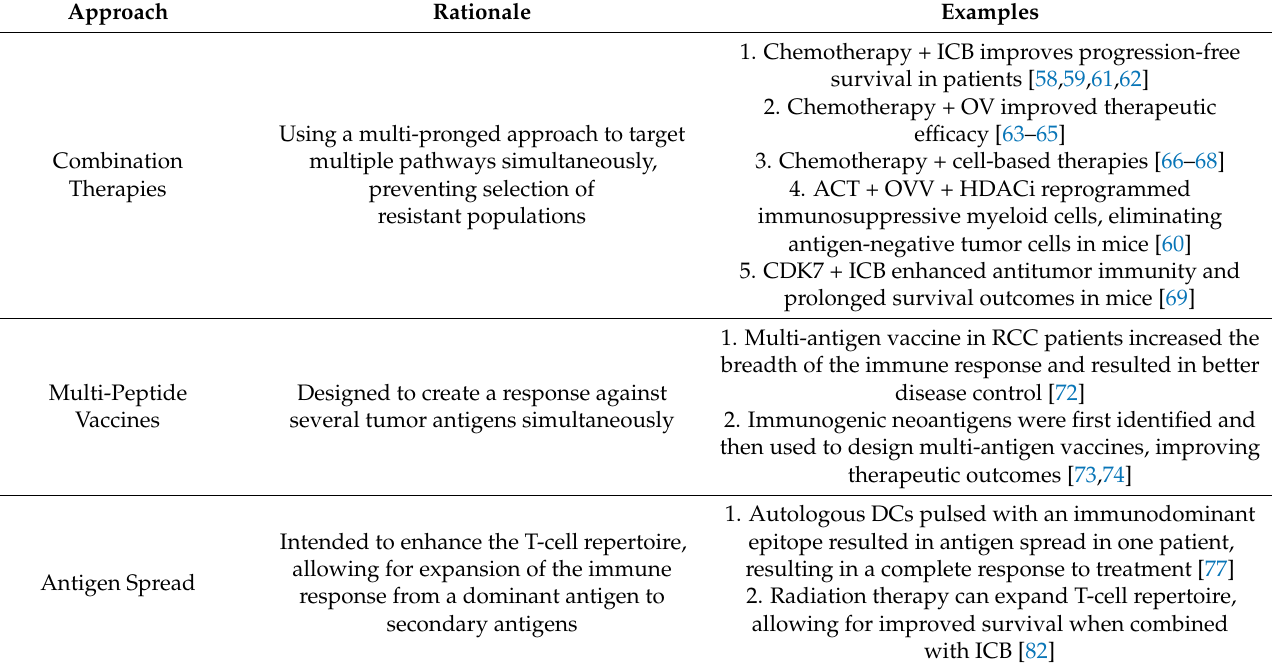
Table 1. Therapeutic strategies to combat tumor heterogeneity. ICB = Immune checkpoint blockade, OV = oncolytic virus, ACT = adoptive T cell transfer, OVV = oncolytic virus vaccine, HDACi = class I histone deacetylase inhibitor, CDK7 = cyclin-dependent kinase 7, RCC = renal cell